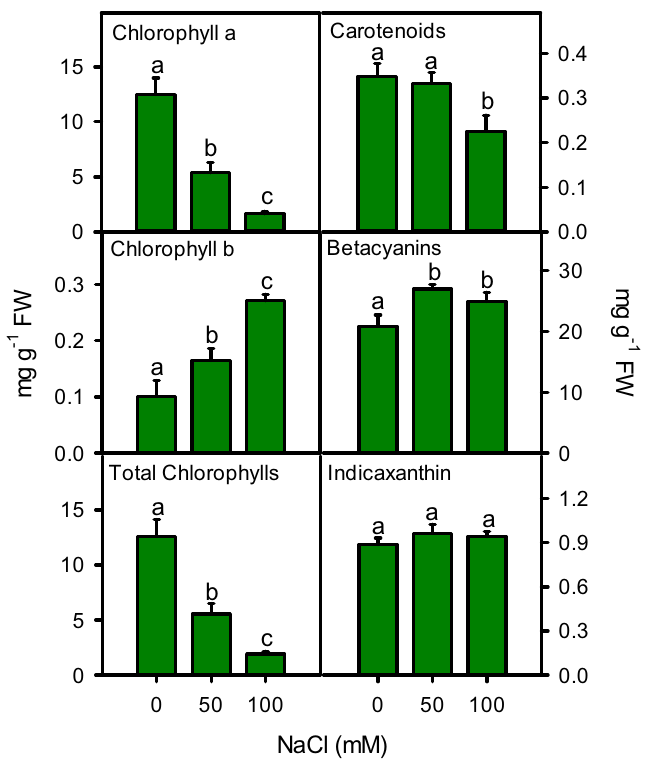
Figure 4. Pigments including chlorophyll a , b , total chlorophylls, carotenoids, betacyanins, and indicaxanthin of Moringa oleifera leaves under different salinity treatments. Different letters indicate significant differences at P <